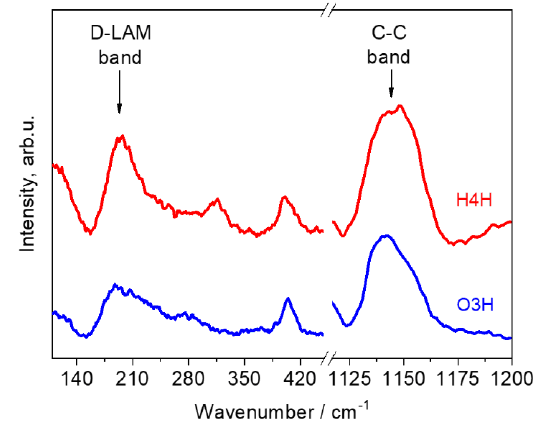
Figure 7. D-LAM and C–C bands of isomers with formula C 24 H 50 : 1-hexene tetramer (H4H) and 1-octene trimer (O3H).